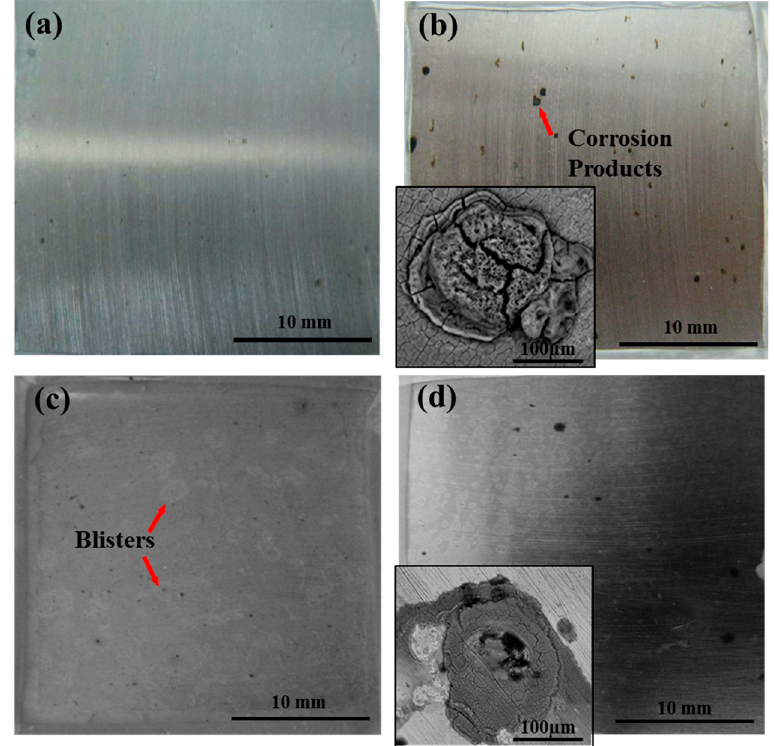
Figure 2. Macroscopic morphology pictures of epoxy varnish (EV) coating/steel under different pressure conditions: under ordinary pressure ( a ) after immersion 192 h and ( b ) after 720 h (30 d); under hydrostatic pressure ( c ) after 192 h and ( d ) after 720 h (30 d). The corresponding microscopic corrosion morphologies after 720 h under two conditions are shown in ( b ) and ( d ), respectively.